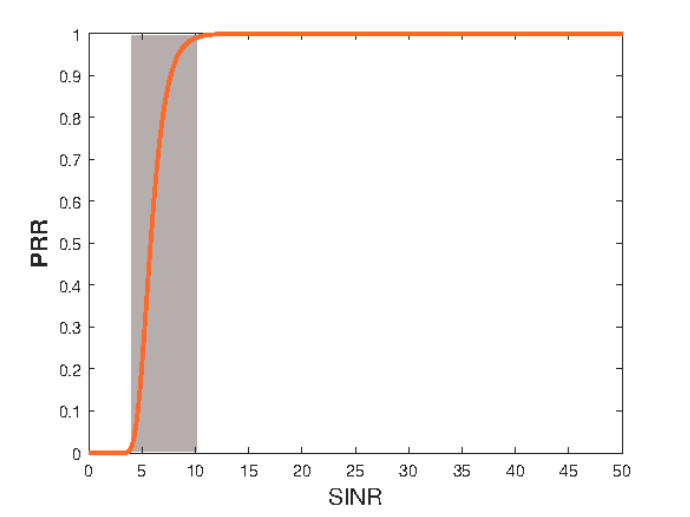
Figure 2. PRR as a function of